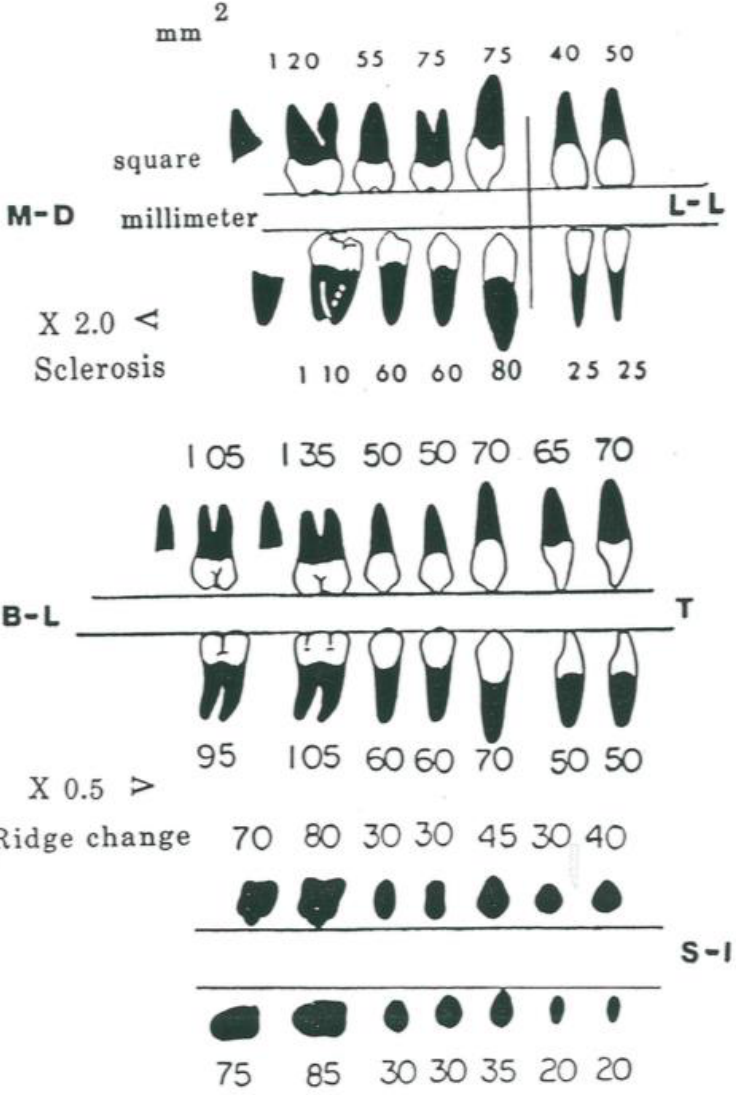
Figure 2. Mean values of root surface presentation on three dimensions of space for permanent teeth: Sagittal, transverse, and vertical. Rotation values are equals to sagittal data.